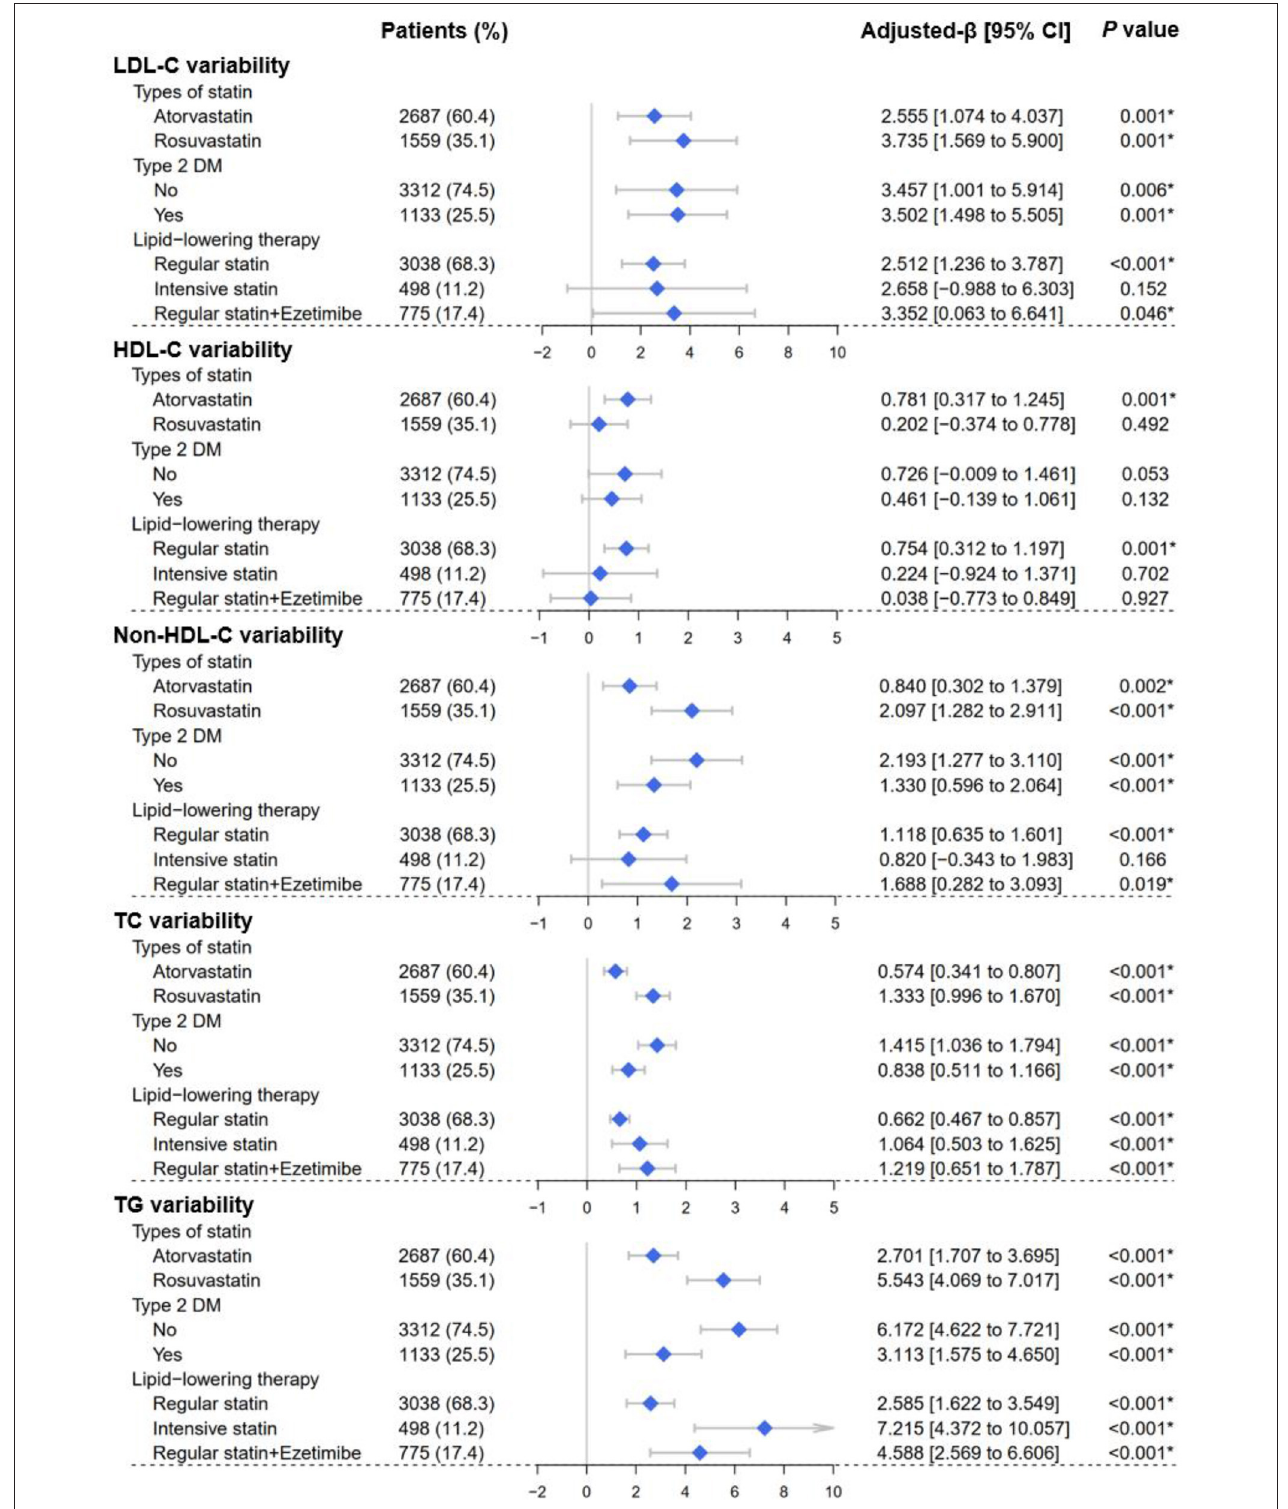
FIGURE 5 | Forest plots of the lipid variability analyses. Forest plots depicted the effect of average follow-up HbA1c levels on visit-to-visit variability of lipid profiles, including LDL-C, HDL-C, Non-HDL-C, TC, and TG. Lipid variability was represented by the variability independent of the mean (VIM). Subgroups were determined according to Type 2 DM (yes or no), types of statins (atorvastatin or rosuvastatin), and lipid-lowering therapy strategy (regular statins/intensive statins/statins plus ezetimibe). LDL-C, low-density lipoprotein cholesterol; HDL-C, high-density lipoprotein cholesterol; Non-HDL-C, non-high-density lipoprotein cholesterol; TC, total cholesterol; TG, triglyceride; DM, diabetes mellitus. * P < 0.05.